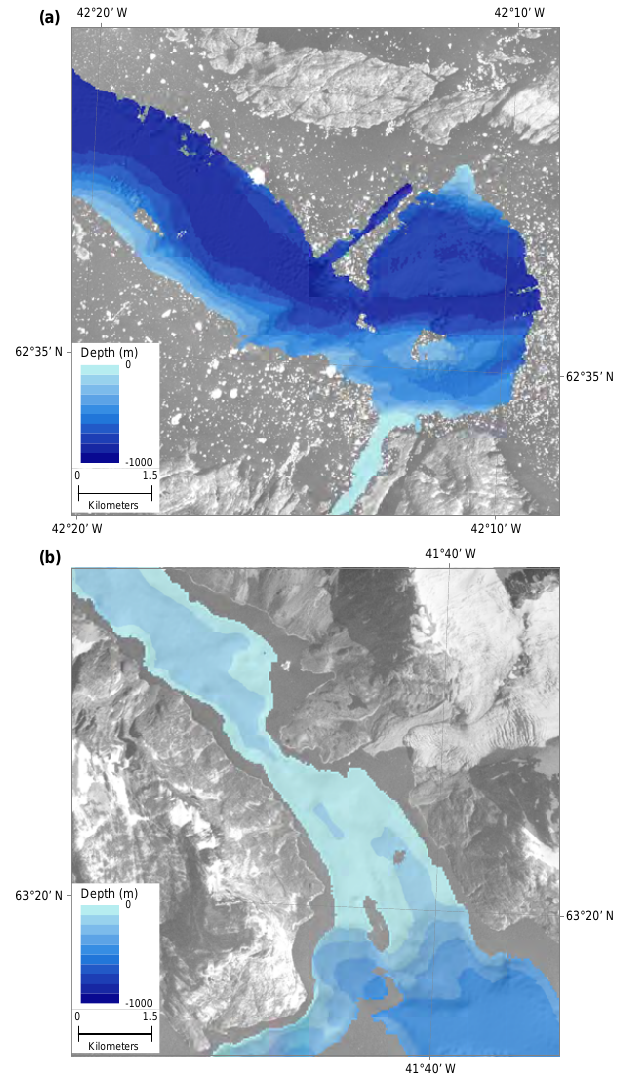
Figure 5. Enlargement of the mapped bathymetry at the mouth of Timmiarmiut Fjord (a) and around the sill region in SSsund (b) . Both maps overlay a 1981 orthophoto derived from aerial